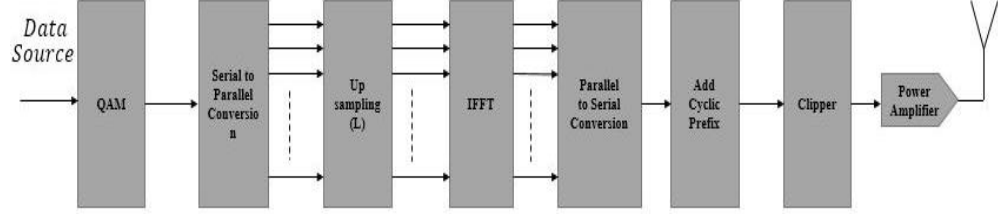
Figure 1. OFDM (orthogonal frequency divisional multiplexing) transmit blocks with clipping.